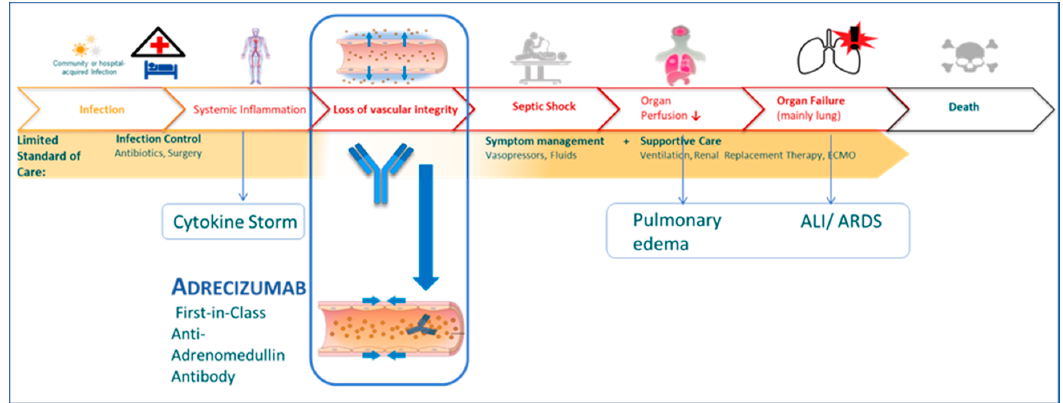
Figure 3. Hypothesis of the loss of vascular integrity preceding septic shock, and Adrecizumab improving endothelial function and vascular integrity in critically ill patients with COVID-19. COVID-19 = coronavirus disease 2019; ALI = acute lung injury; ARDS = acute respiratory distress syndrome.